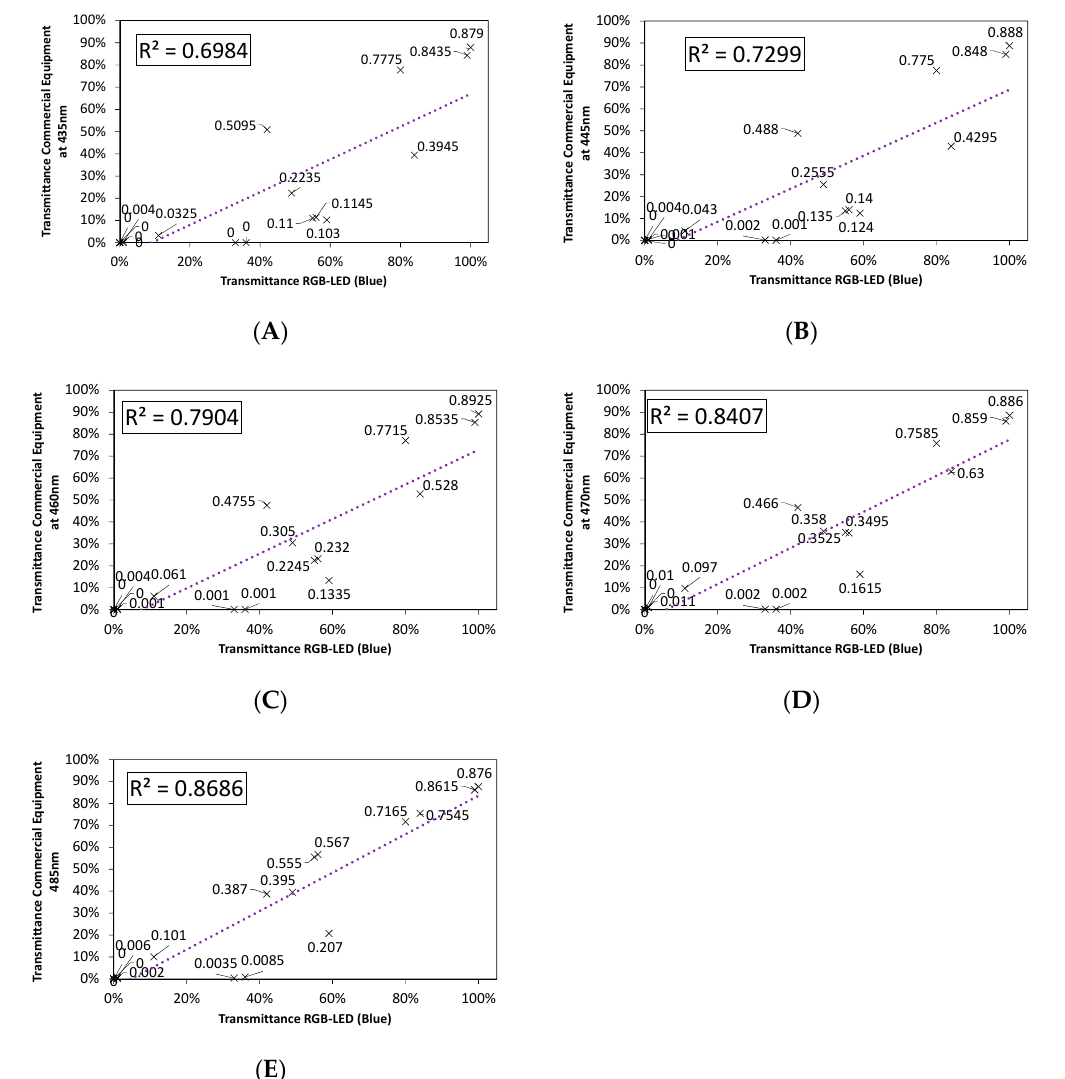
Figure 10. Comparison of the fit for the emission spectrum of the Blue LED to: ( A ) 435 nm, ( B ) 445 nm, ( C ) 460 nm- λ Peak, ( D ) 470 nm, and ( E ) 485 nm.